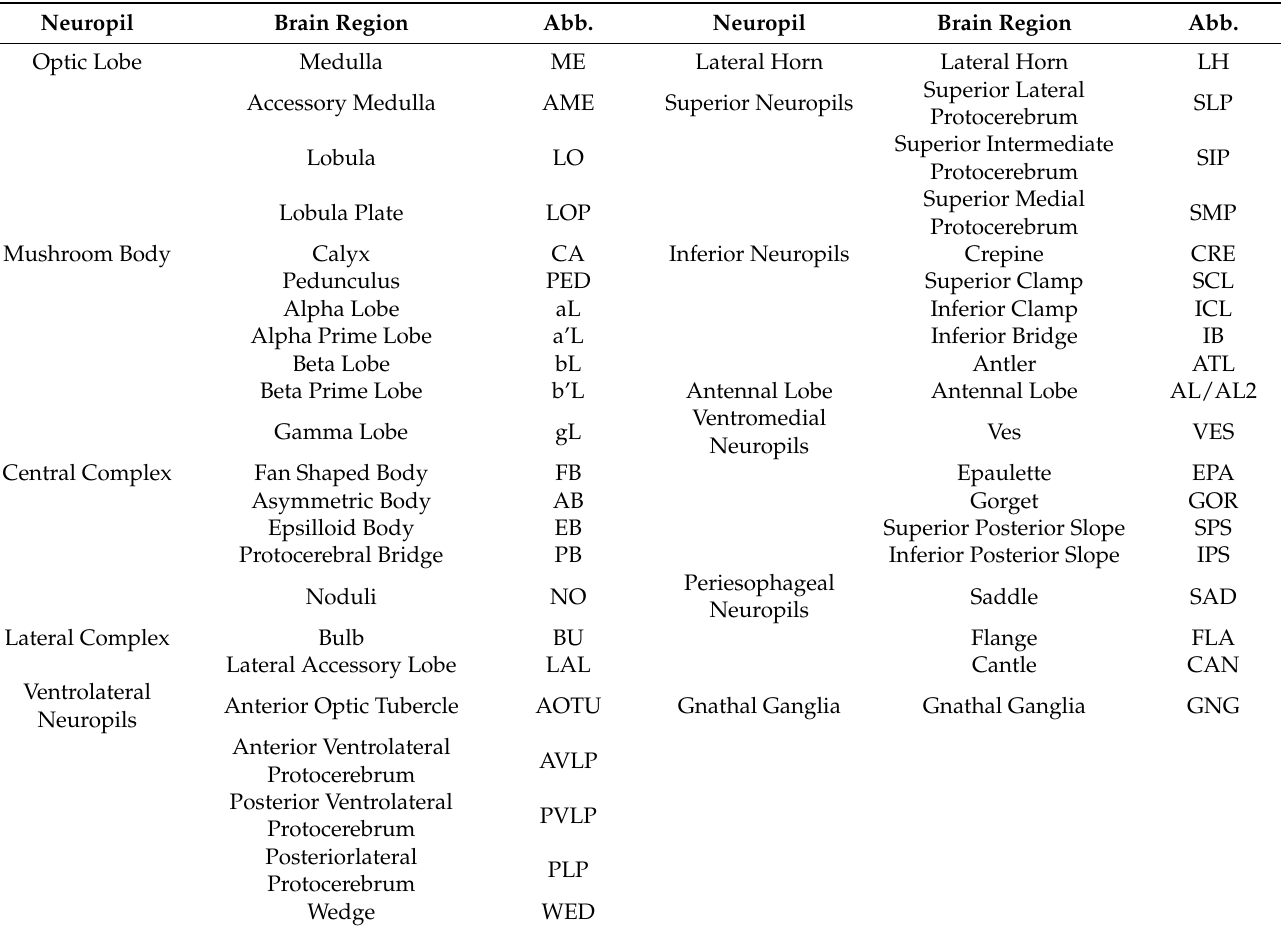
Table 1. Nomenclature for fruit fly hemibrain by synapse-rich neuropil, brain region and its abbrevia- tion [19]. The list is restricted to regions which are referenced in this paper. Abb. = abbreviation of brain region